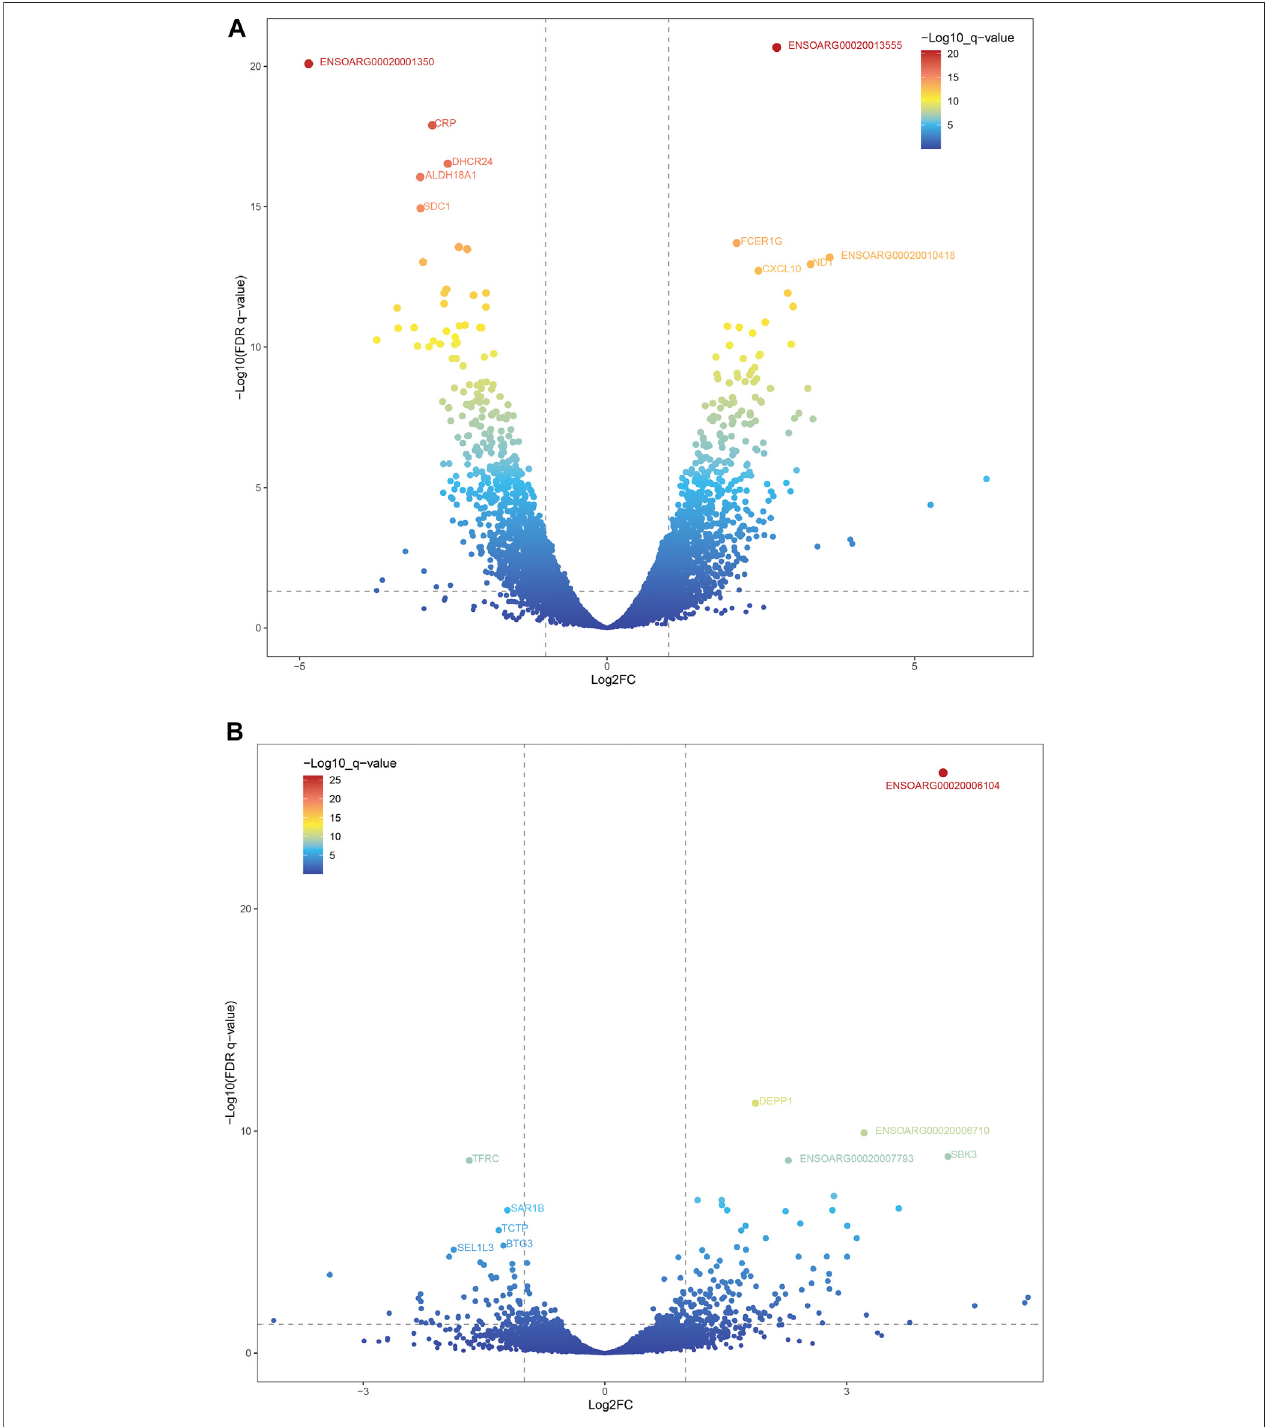
FIGURE 1 | The volcano plots of DEGs of the two groups. Two vertical lines indicated the expression fold change (DP vs. STH) ≥ 1 and ≤ − 1, respectively, and the horizontal lineindicated the adjusted p -value (FDR q -value) of 0.05. The color of the dot represented the FDR ( q -value) levels. The top 5 DEGs were labeled on the plots. (A) DEGs of the liver; (B) DEGs of the